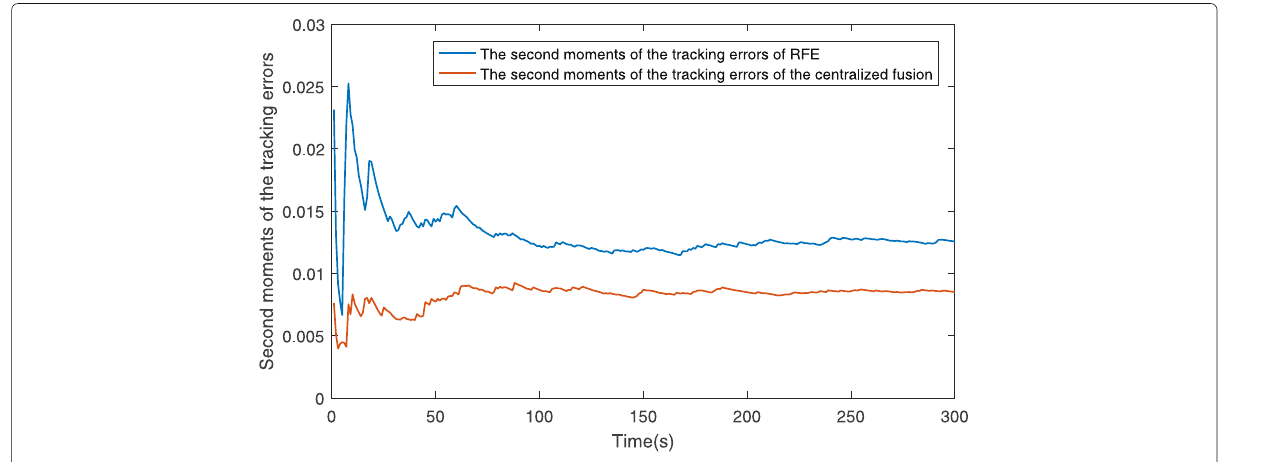
A robust fusion estimation in distributed systems are derived in this paper which minimizes the worst-case esti- mation errors on some given parameter set. Compared with the BLUE fusion, the RFE tracks well without the information of the cross-covariance between sensor esti- mates. At the same time, simulation example shows that the tracking performance of RFE is comparable to that of the CI